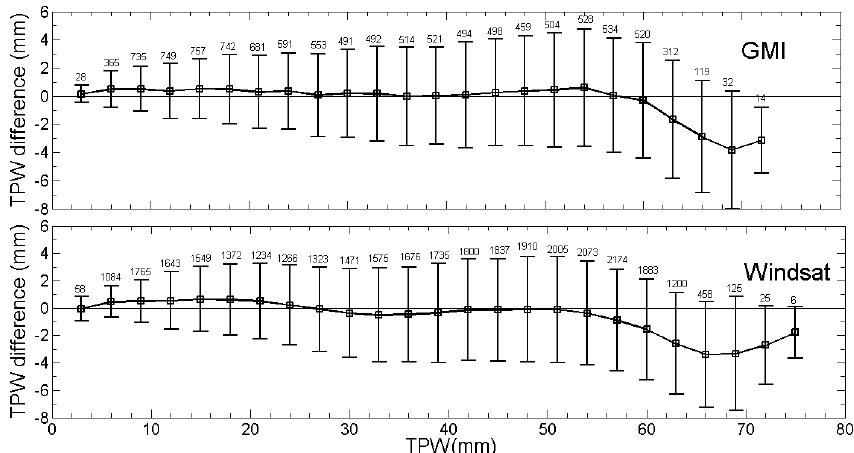
Figure 7. Mean values and standard deviations of TPW differences as a function of radiosonde TPW in each 3mm TPW bin for each satellite.